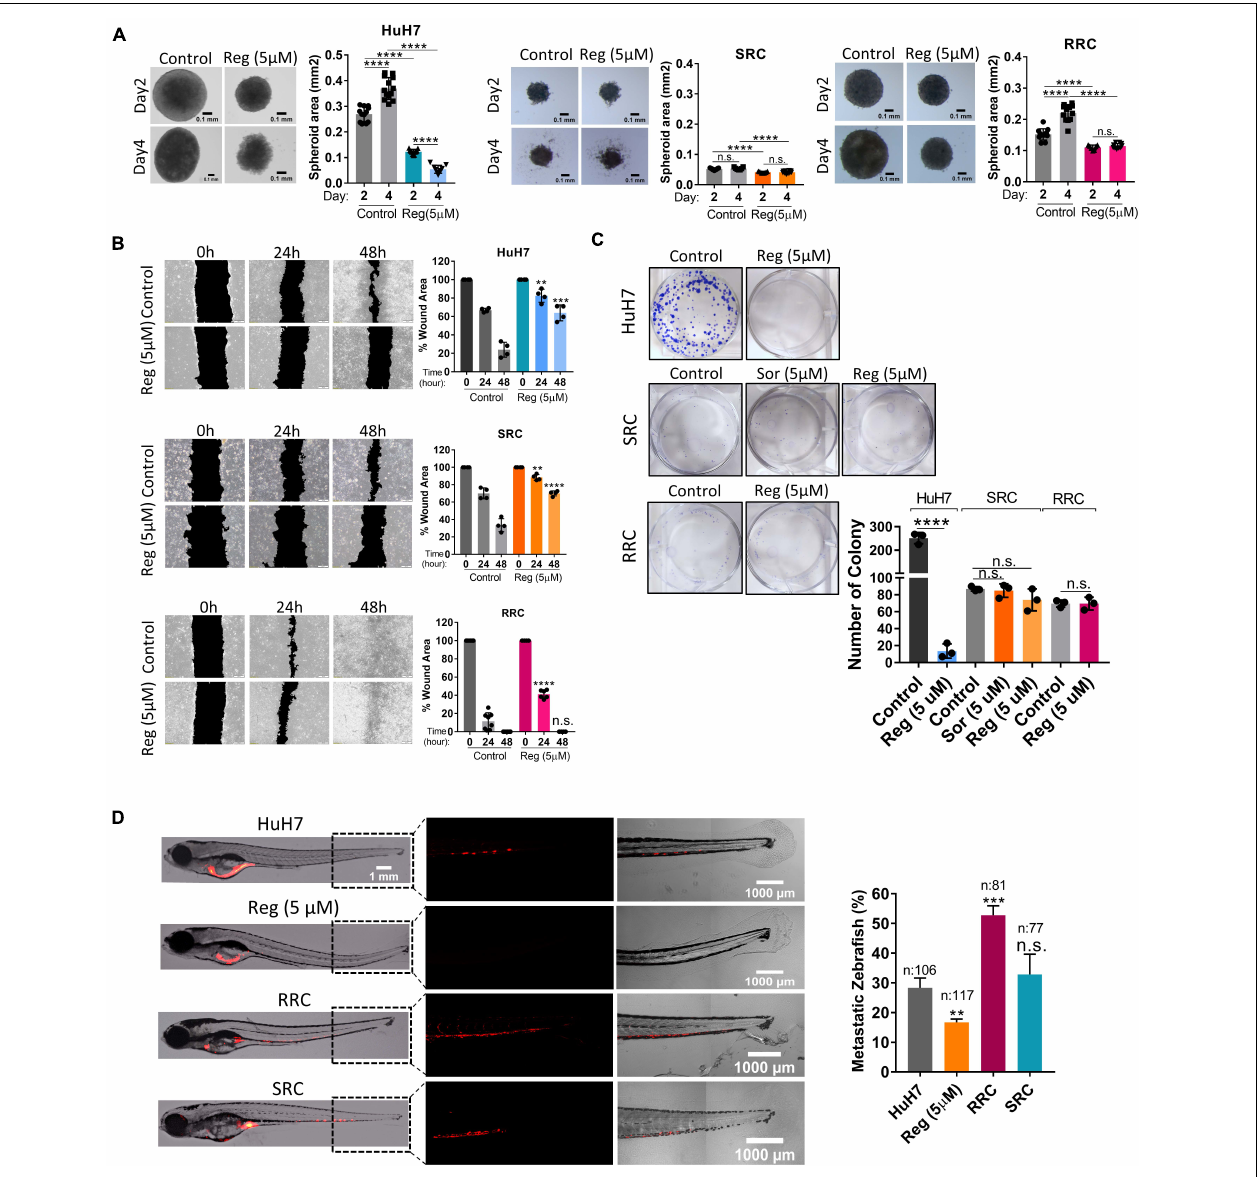
FIGURE 7 | Regorafenib resistant cells demonstrate increased in vitro and in vivo migration ability. (A) 3-D spheroids were formed from parental HuH7, SRC and RRC cells with or without regorafenib treatment. Spheroid area was calculated using Image J. (B) Scratch assay and (C) Colony formation assay was performed in parental HuH7, SRC and RRC cells with or without regorafenib treatment. Wound area was calculated using Image J MRI wound healing tool. (D) Parental HuH7 cells, 5 µ M regorafenib treated HuH7 cells, SRC and RRC lines were implanted into the yolk sac of 2 dpf zebrafish embryos. 5 days after injection, migration to the tail was quantified. Representative images of zebrafish embryos were acquired on a Carl Zeiss LSM 880 AxioObserver confocal microscope with a EC Plan-Neofluar 10x/0.30 M27 objective. p > 0.05 (n.s.), p ≤ 0.05 (*), p ≤ 0.01 (**), p ≤ 0.001 (***), p ≤ 0.0001 (****). Error bars indicate standard deviation